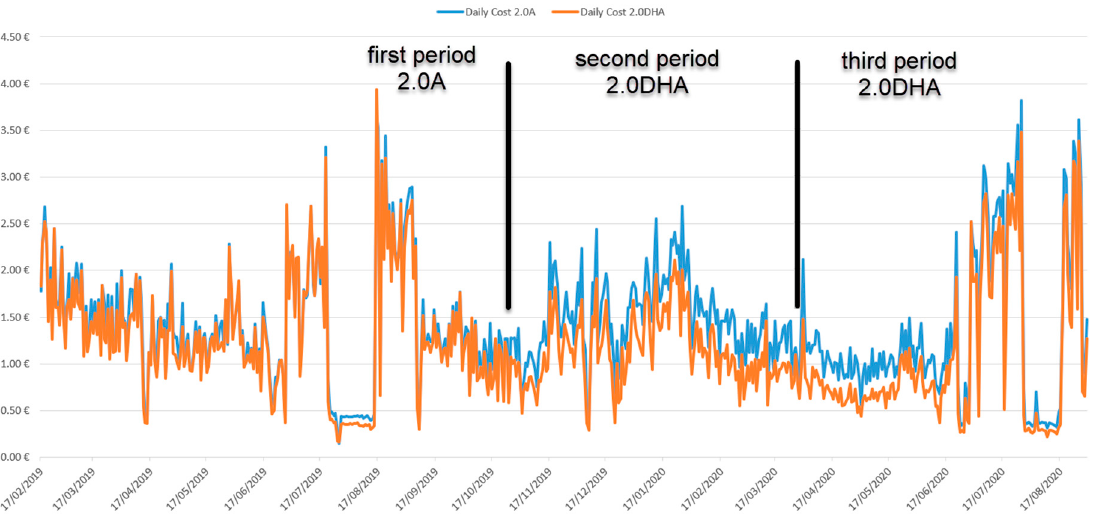
Figure 22. Comparison of the cost of energy consumed daily between the 2.0A (blue) and 2.0DHA (orange) tariffs from 17